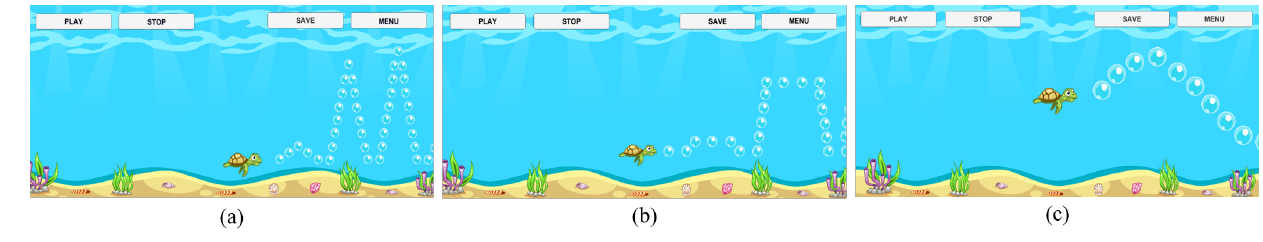
Figure 4. ( a ) “Ramp”, ( b ) “Square Wave”, and ( c )